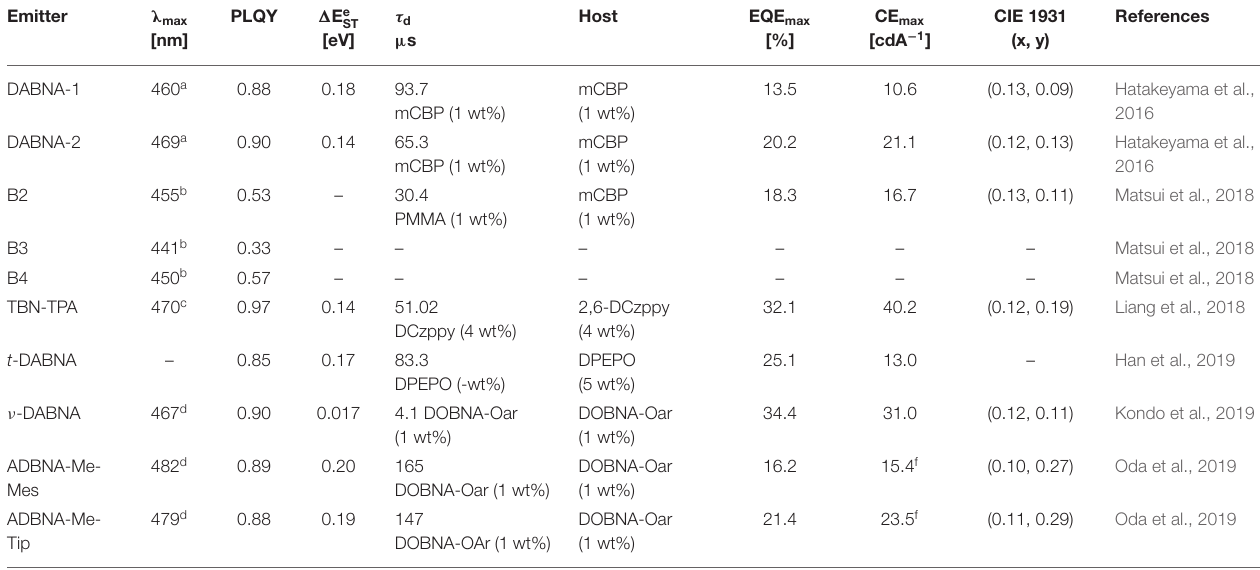
TABLE 5 | Summary of photophysical properties and device performances of the multiple resonance (MR)-thermally activated delayed fluorescence (TADF)-based blue TADF materials.